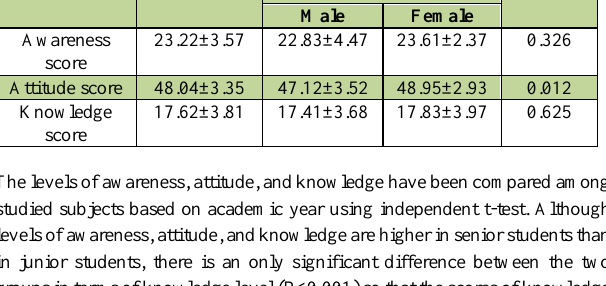
Table 1: Comparison of levels of awareness, attitude, and knowledge of dentistry students regarding Evidence-Based Dentistry (EBD) among males and females. Variables